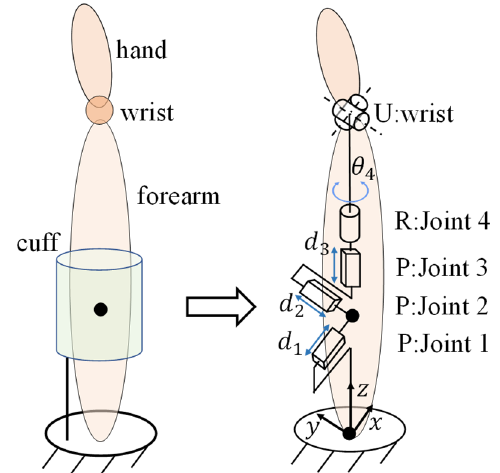
Figure 4. The model of human limb [13]. Reprinted with permission from ref. [13]. 2021, Jc- IFToMM.